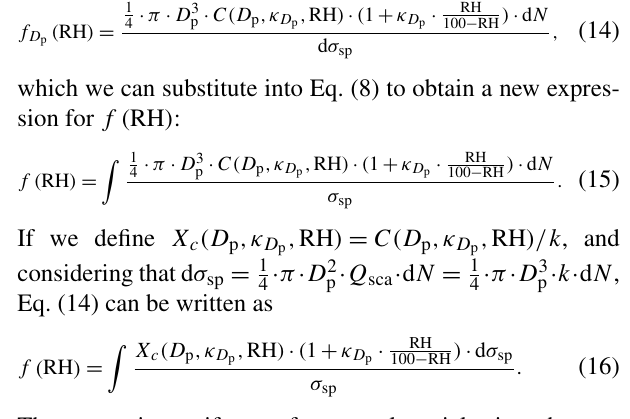
κ D values (Fig. 2a). In the diameter range below 200 nm, p ∂f D p ( RH ) is very high, displaying a maximum near 60 ∂κ D p